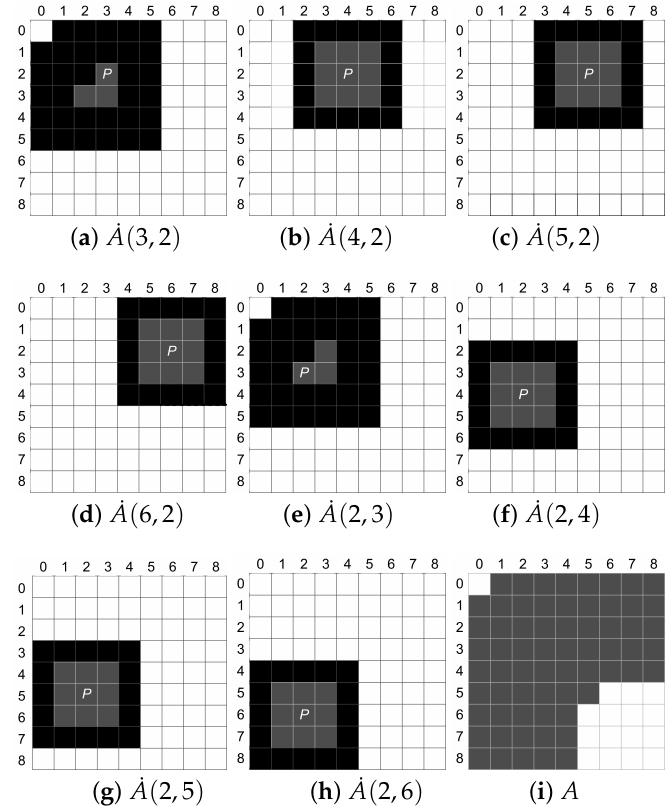
Figure 9. Illustrations of pattern reconstruction from the skeleton table. Reconstructed partial pattern from ( a ) RSP ( 3,2 ) , ( b ) RSP ( 4,2 ) , ( c ) RSP ( 5,2 ) , ( d ) RSP ( 6,2 ) , ( e ) RSP ( 2,3 ) , ( f ) RSP ( 2,4 ) , ( g ) RSP ( 2,5 ) and ( h ) RSP ( 2,6 ) . Here, the reconstructable information 1-neighbor r ∈ R ( P ) is displayed by a gray square. ( i ) shows the final reconstructed pattern A with the union of these partial patterns ( ˙ A )s. Pattern Reconstruction: Procedure of Pattern Reconstruction from the Skeleton Table 1.